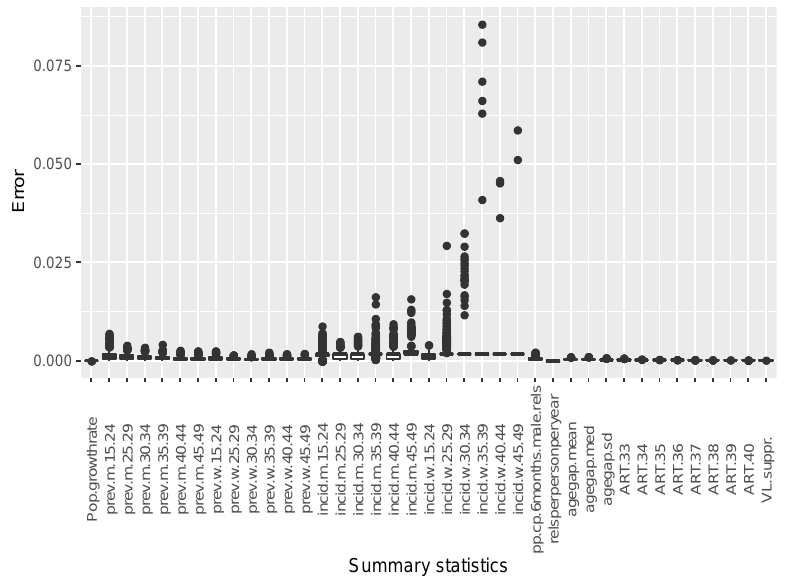
Figure A2. Relative error between mean the value of epi-behavioural benchmark summary features and those associated to retained parameter values during